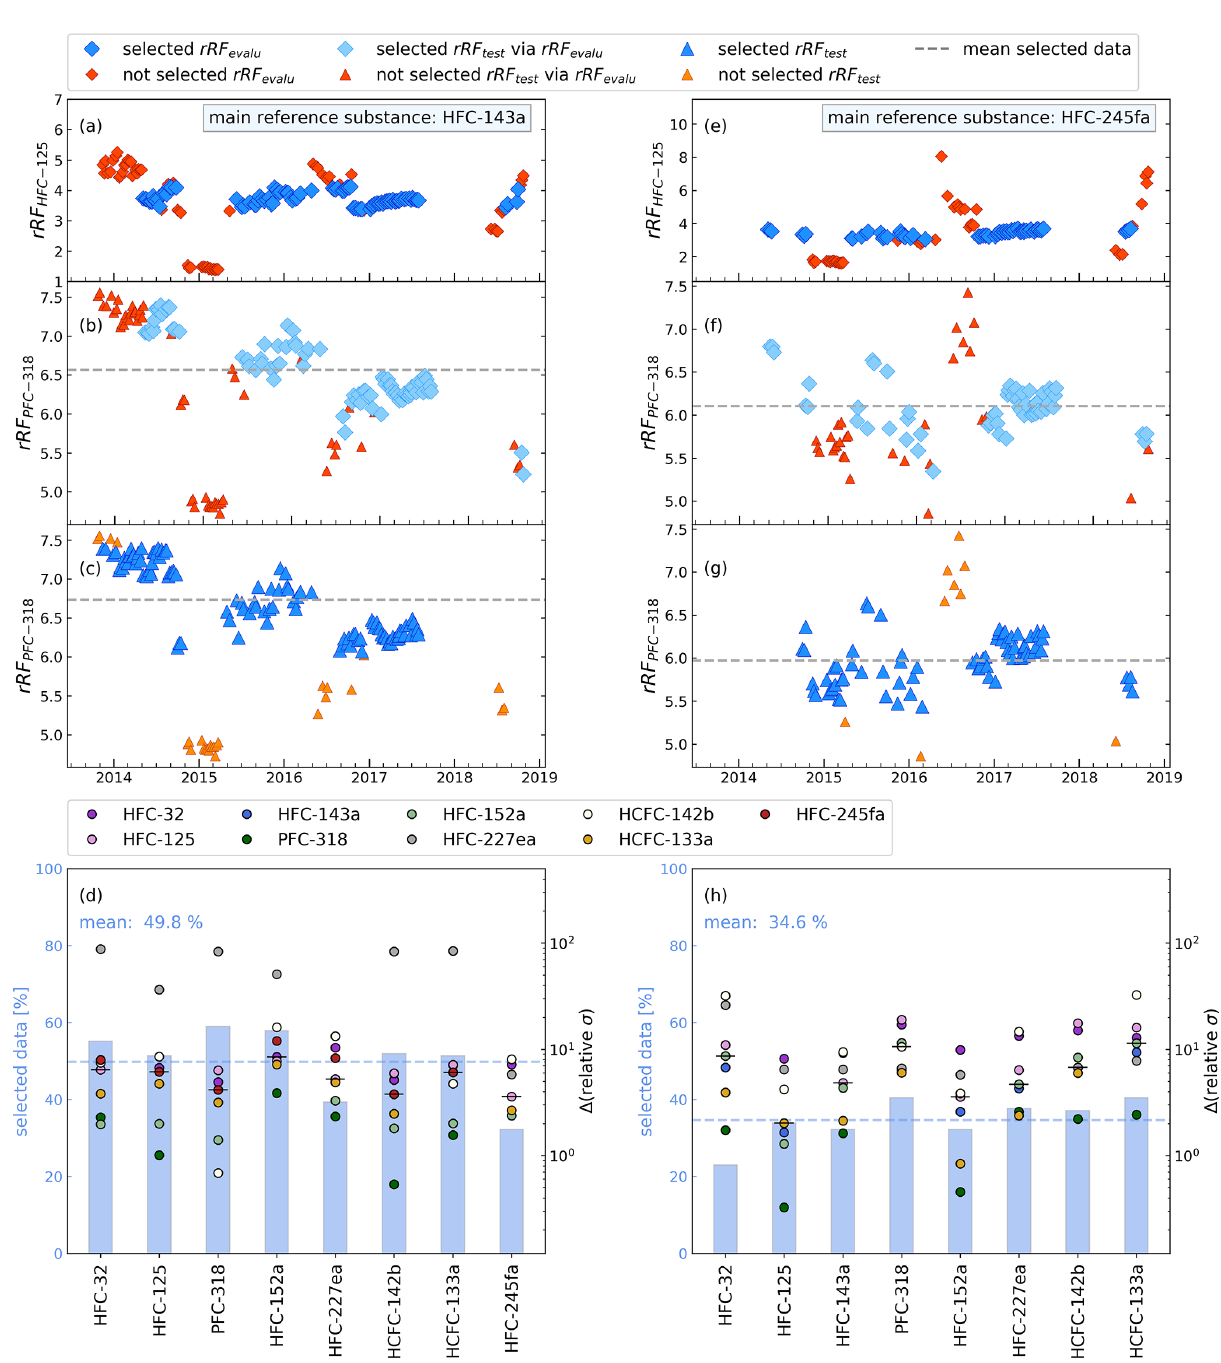
Figure 5. Illustration of constant rRF data selection, using the standard calibration measurements during the weekly flask sampling mea- surements, using two different main reference substances (HFC-143a a–d , HFC-245fa e–h ) and an evaluation substance (HFC-125). Pan- els (a) and (e) show results of the application of the 10% filter. Red data points are excluded as outliers. Panels (b) and (f) illustrate which data of main reference and test substances (here PFC-318) would be chosen applying the resulting selection of panels (a) and (e) . Panels (c) and (g) show the result of data selection based on the main reference and the test substance directly. The dashed lines indicate the means of the rRF of the selected data. In panels (d) and (h) , vertical bars show percentages of data selected for the respective main reference substance, and coloured symbols show the differences of the relative standard deviations of the rRF of main reference and test substance selected via main reference (HFC-143a in panel d and HFC-245fa in panel h ) and all evaluation substances ( x axis) between the originally selected rRF via main reference and test